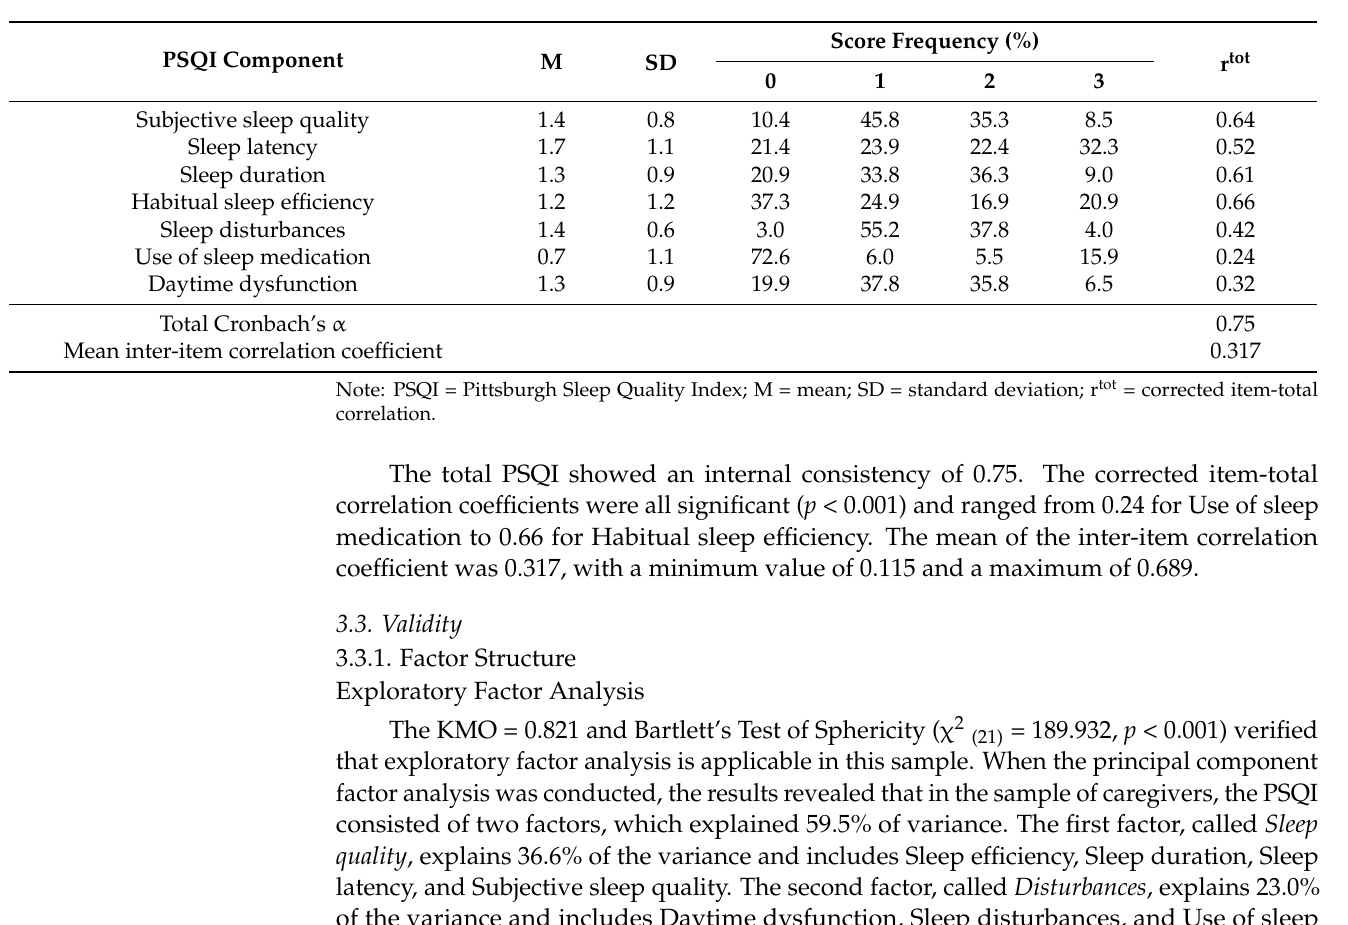
Table 2. Means, standard deviations, score frequency, and corrected item-total correlation for each component of the